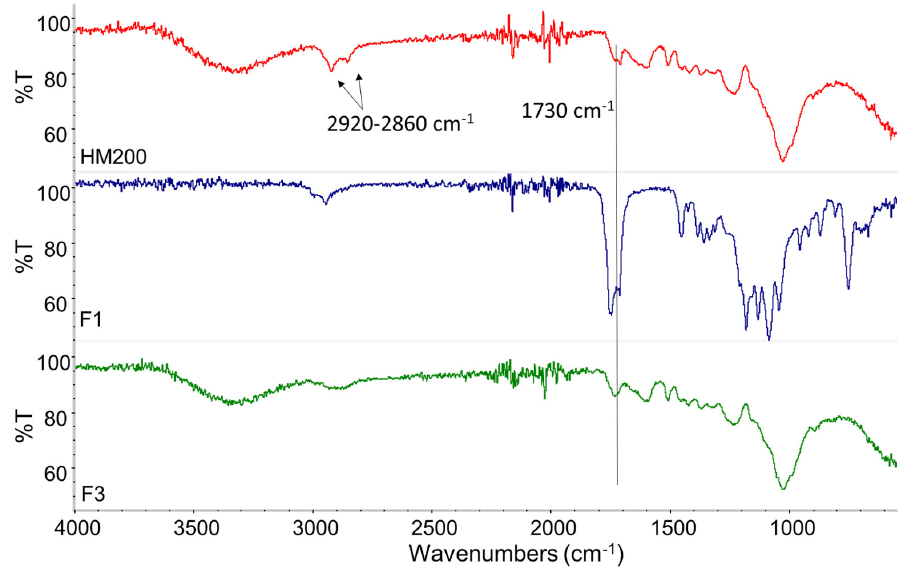
Figure 5. Comparison of the FTIR spectra of HM200 composite and the pure matrix and HSP.